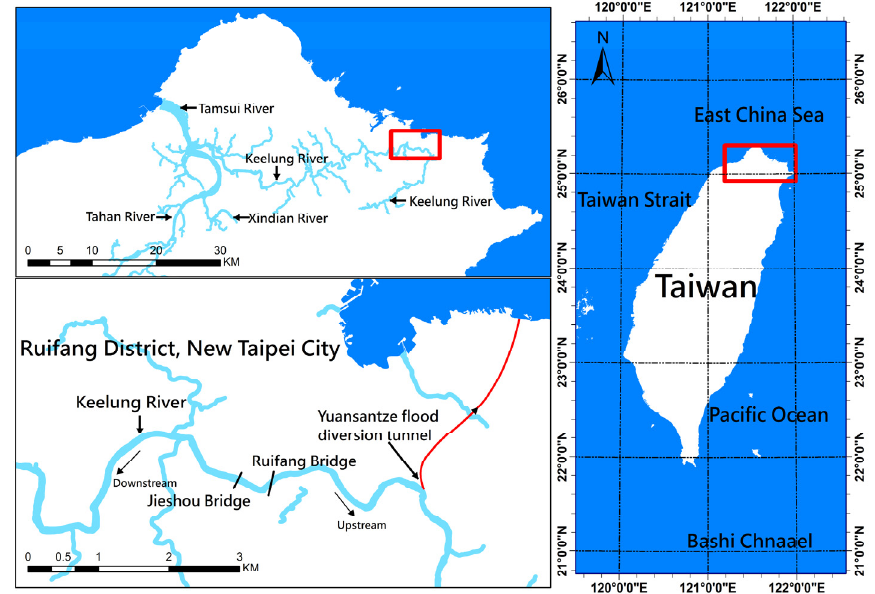
Figure 1. Map of the study area. (White, blue, and cyan represent land, ocean, and river,